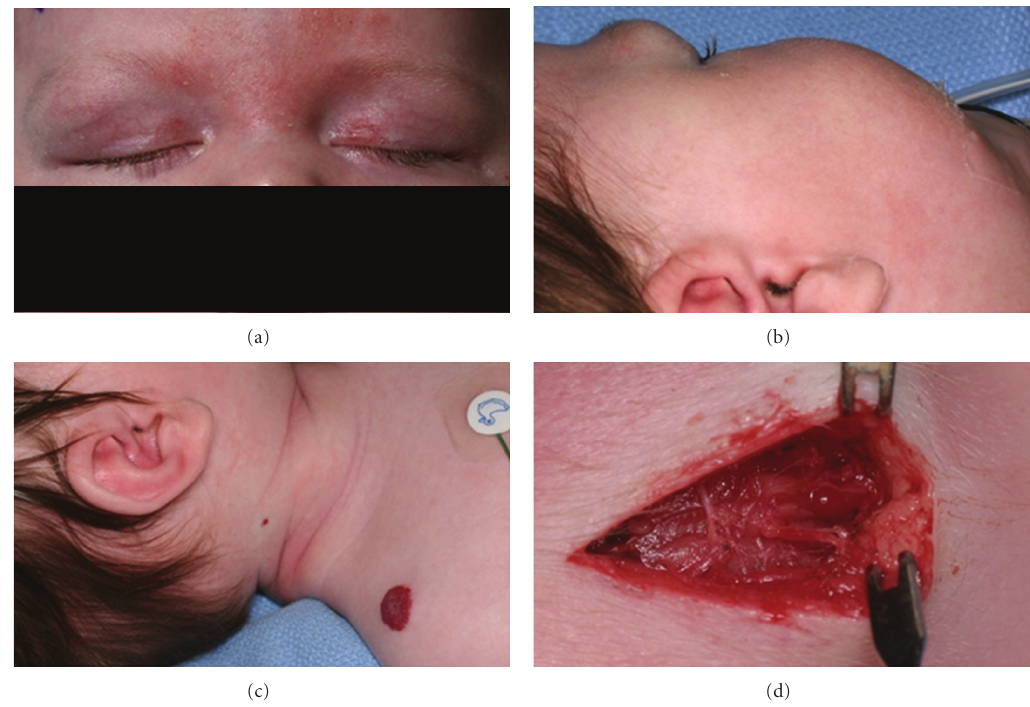
Figure 1: (a) Firm, oblong 1.5 × 1.0 cm sized rubbery mass over the right temporal brow. (b) Lesion found under the right brow. (c) Capillary hemangioma on the right shoulder and right neck. (d) Incision through the eyebrow on the temporal edge made to evaluate the